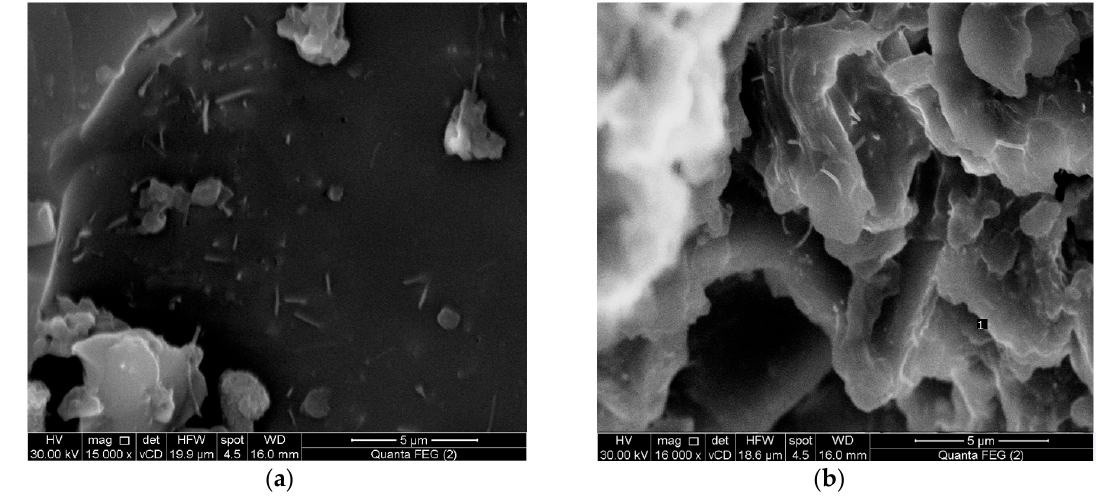
Figure 1. Field Emission Scanning Electron Microscope (FESEM) images for ( a ) 2.0 wt %